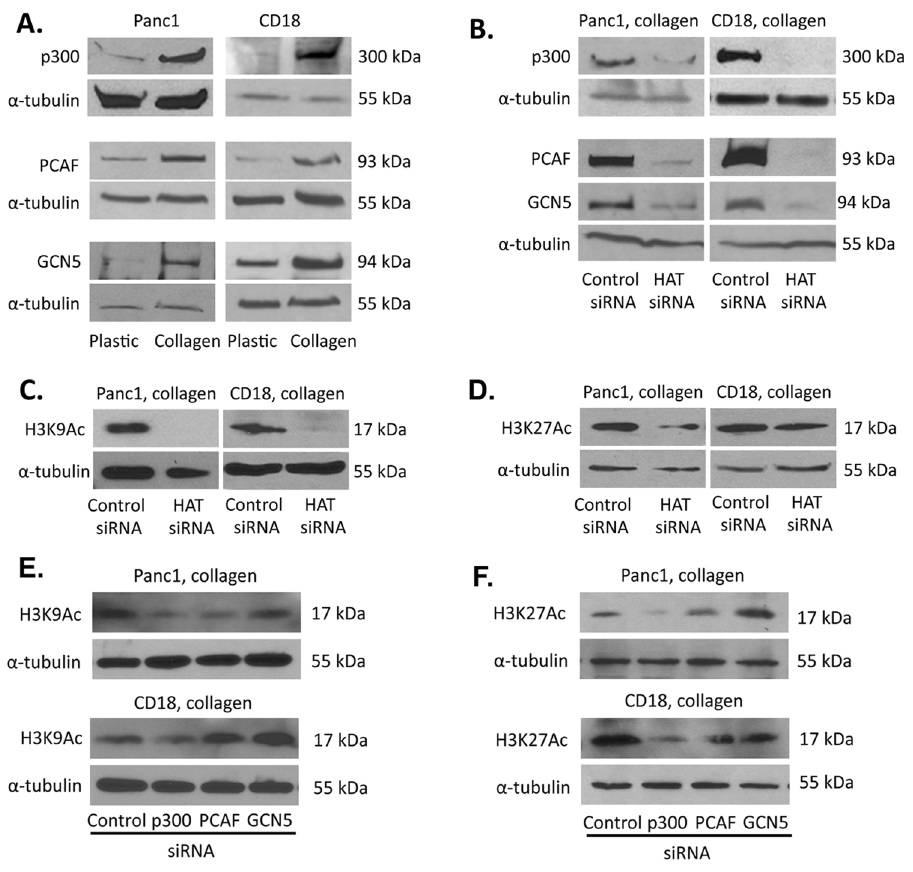
Figure 3. Collagen increases expression of p300, PCAF and GCN5 histone acetyltransferases. A . Panc1 and CD18 cells were grown on tissue culture plastic or in three- dimensional collagen gels for 24 hours. Cells were lysed and immunoblotted for p300, PCAF and GCN5 histone acetyltrasferases (HATs) using a -tubulin as loading control. The results are representative of three independent experiments B – D . Panc1 and CD18 cells were transfected with control siRNA or with combination of siRNAs against p300, PCAF and GCN5 (HAT siRNA); allowed to recover overnight and then embedded in three-dimensional collagen gels for 24 hours. The lysates were immunoblotted for the corresponding HAT proteins ( B ), and histone H3K9Ac ( C ) and H3K27Ac ( D ). The results are representative of at least three independent experiments. E, F . Panc1 and CD18 cells were transfected with control siRNA or with individual siRNAs against p300, PCAF and GCN5; allowed to recover overnight and then embedded in three- dimensional collagen gels for 24 hours. The lysates were immunoblotted for histone H3K9Ac ( E ) and H3K27Ac ( F ). The results are representative of three independent experiments.